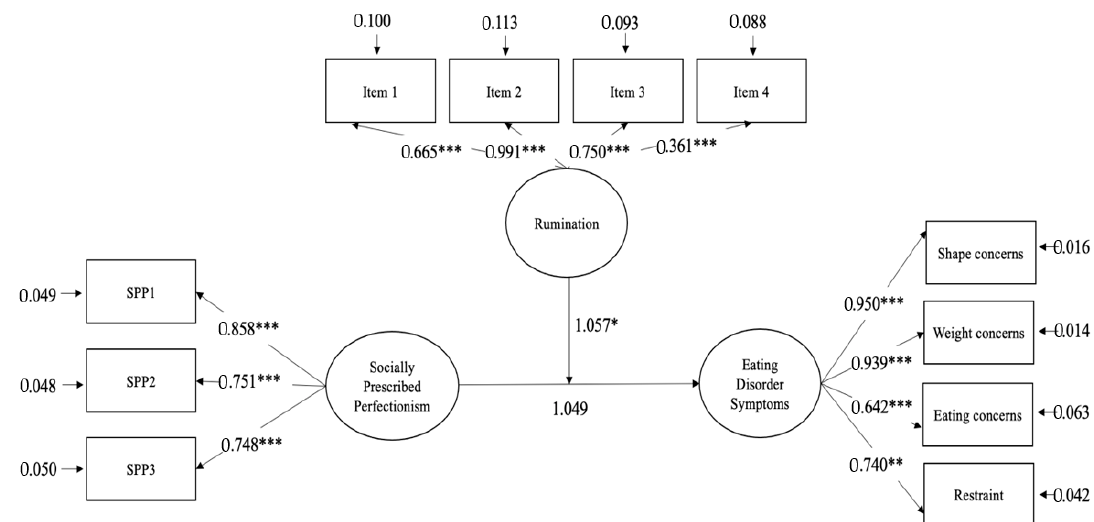
Figure 1. Adjusted structural equation model with rumination as a moderator for the pathway between socially prescribed perfectionism and disordered eating. Circles represent latent factors and squares represent indicators. Covariates are not depicted for brevity. Values on the longer, single-headed arrows signify path coefficients. Values for the smaller, single- headed arrows represent residual variances. All coefficients shown are standardized and obtained statistical significance at the 0.05 level. * p < 0.05; ** p < 0.01; *** p < 0.001.